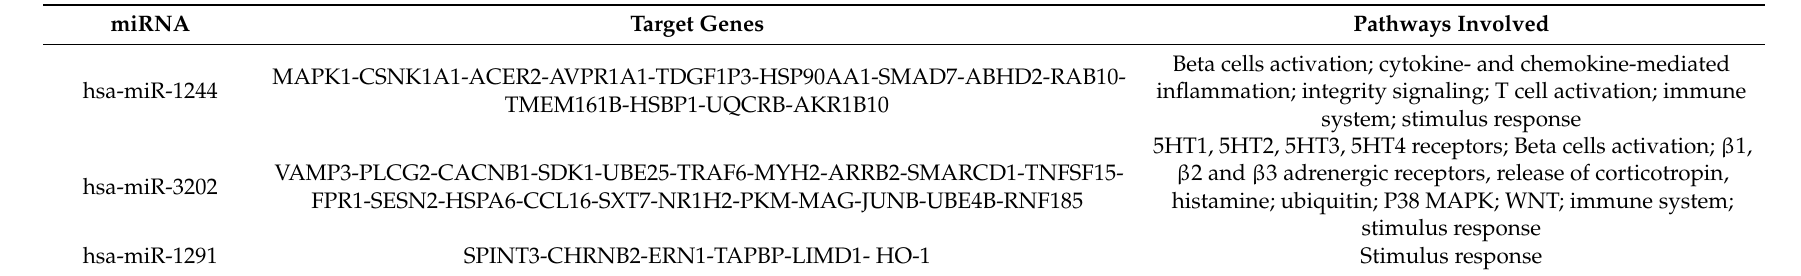
Table 2. In silico analysis of induced microRNAs with the highest fold change and some target genes and pathways involved.